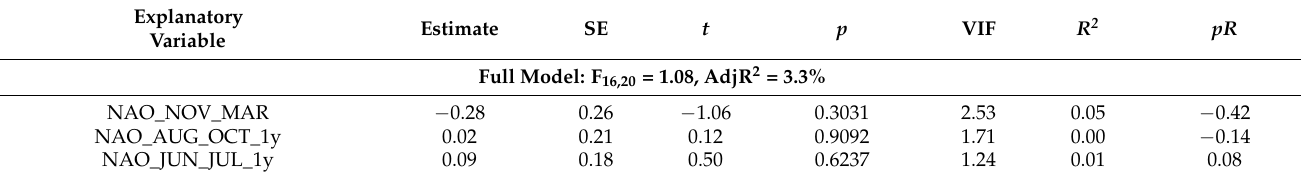
Table A11. Relationships between 15 climate variables and year in full models and Annual Anomaly of the timing of spring migration for the Common Redstart Phoenicurus phoenicurus caught at Bukowo, Poland, in 1982–2021. Estimate—coefficients from multiple regression, SE—standard error of the estimates; t , p — t -test and significance of each estimate, p < 0.05 marked in bold face. VIF—variance inflation factor. R 2 —partial determination coefficients, pR —Pearson’s partial correlation coefficient.